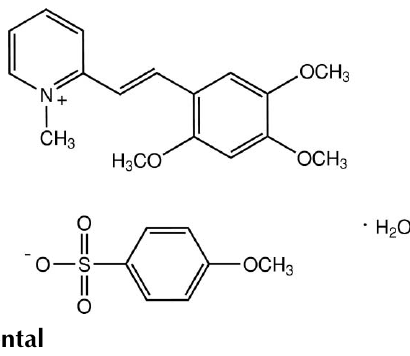
20386 measured reflections 5219 independent reflections 4534 reflections with I > 2 (cid:2) ( I ) R int = 0.044 H atoms treated by a mixture of independent and constrained